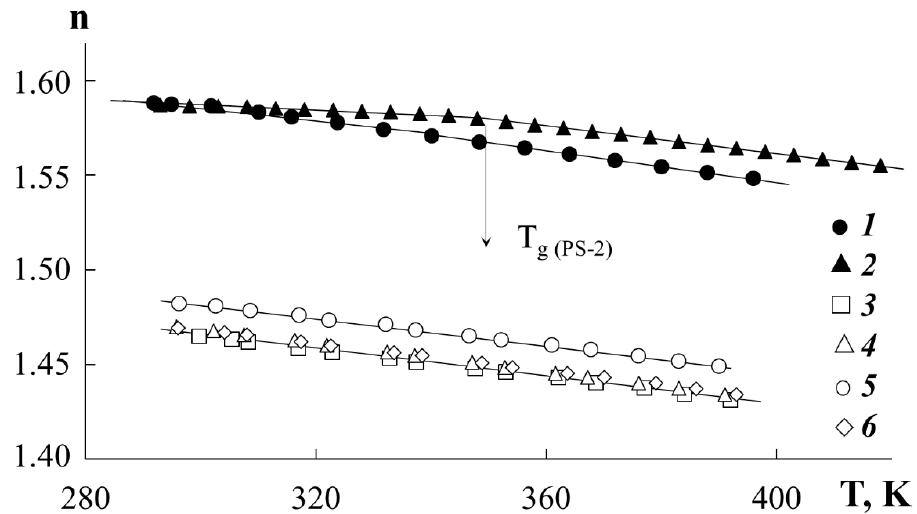
Figure 1. Temperature dependences of the refractive index for PS-1 (1), PS-2 (2), PBA (3), PEA (4), PMA (5) and PEHA (6).